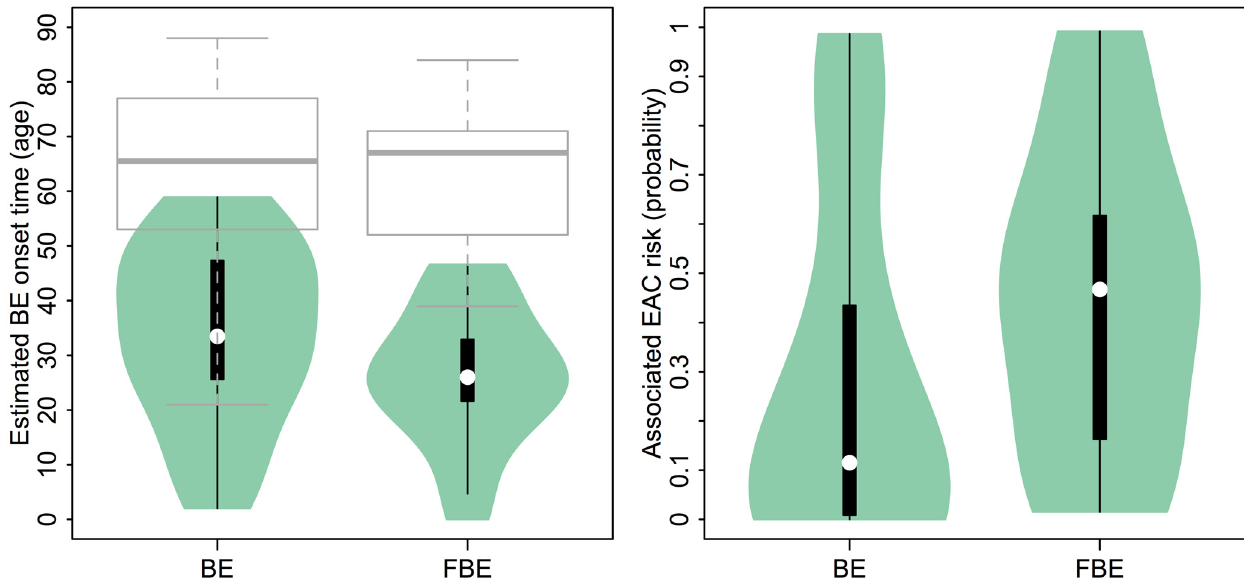
Fig 8. Comparison of Predicted BE onset times and dwell times. (Left panel) Violin plot depicts distributions of median posterior estimates for BE onset times for N 2 = 30 sporadic BE patients in D2 and N 3 = 22 familial BE patients in D3, respectively. The boxplots for similar age-at- diagnosis (i.e., age-at-biopsy) for the two groups is also provided (grey boxplots). (Right panel) Violin plot depicts distributions of EAC risk given median BE onset age estimates for general BE patients in D2 and FBE patients in D3, respectively.